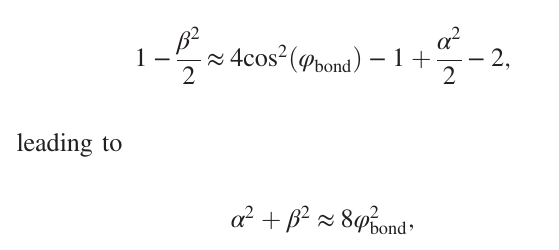
ffiffiffi p 2 φ . bond